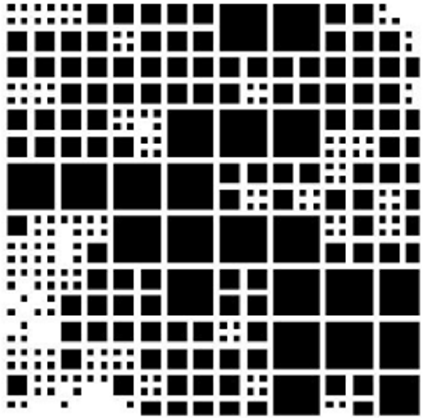
Figure 4. An example of a quadratic tree decomposition image.